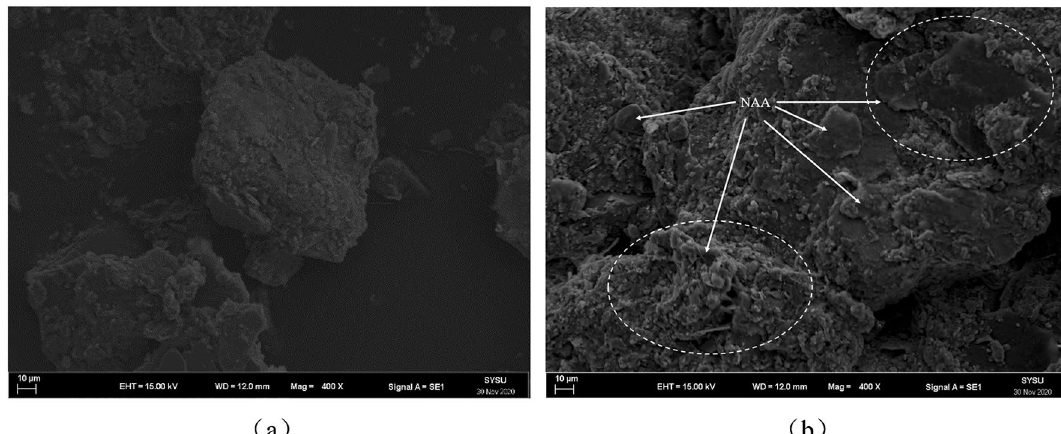
Figure 8. SEM of the microstructure of soil samples. ( a ) Natural soil ( × 400), and ( b ) NAA treated